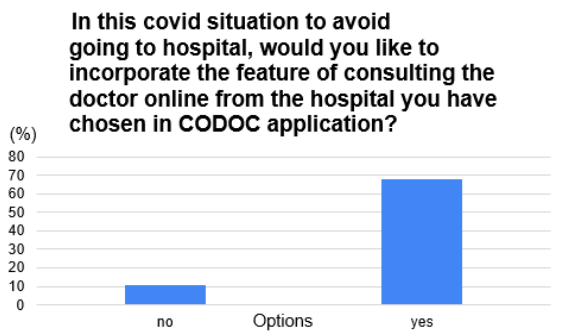
Fig. 5. Survey results for question